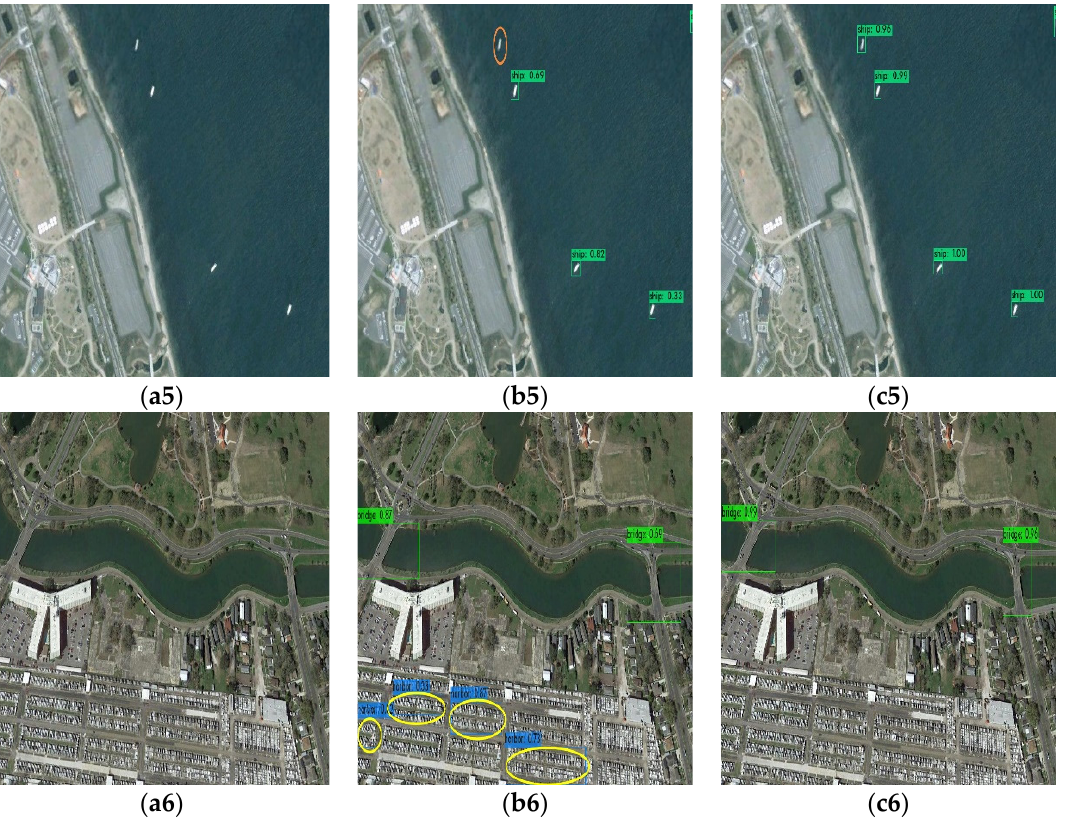
Figure 9. Comparison of the detection effect of YOLO v4 and Ours. ( a1 – a6 ) is the original image, ( b1 – b6 ) is the YOLO v4 detection result, ( c1 – c6 ) is the detection result of this algorithm. Table 5. LEVIR dataset comparison